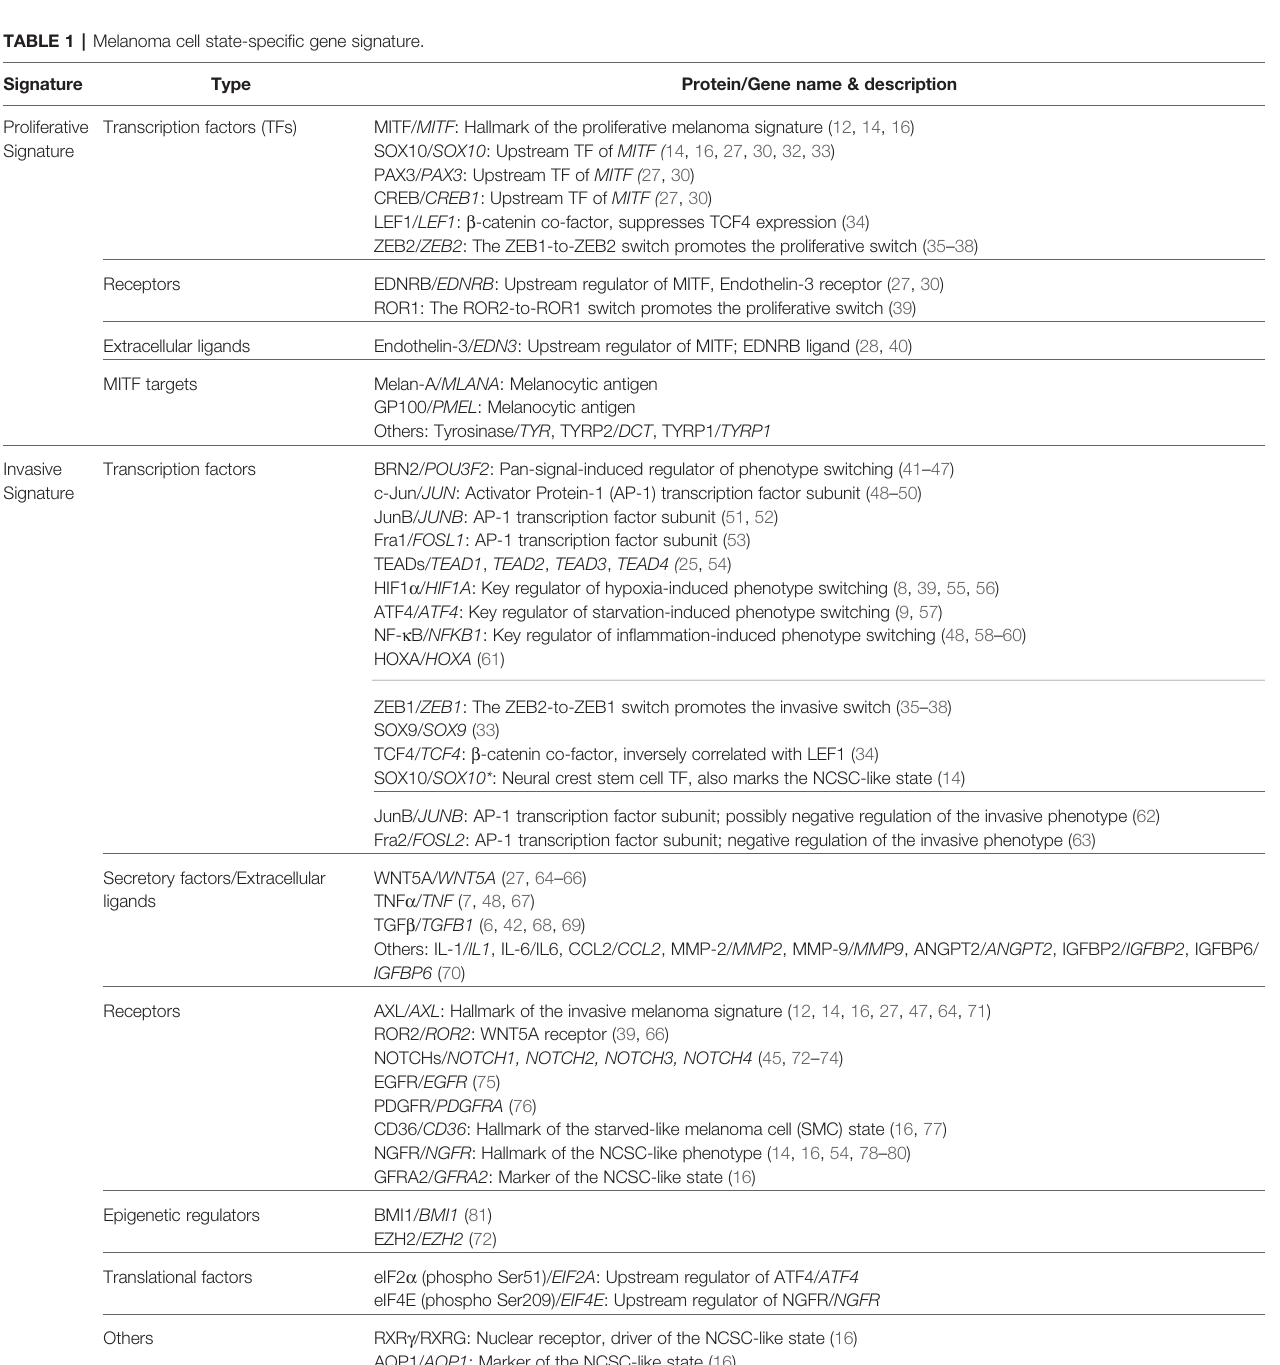
TABLE 1 | Melanoma cell state-speci fi c gene